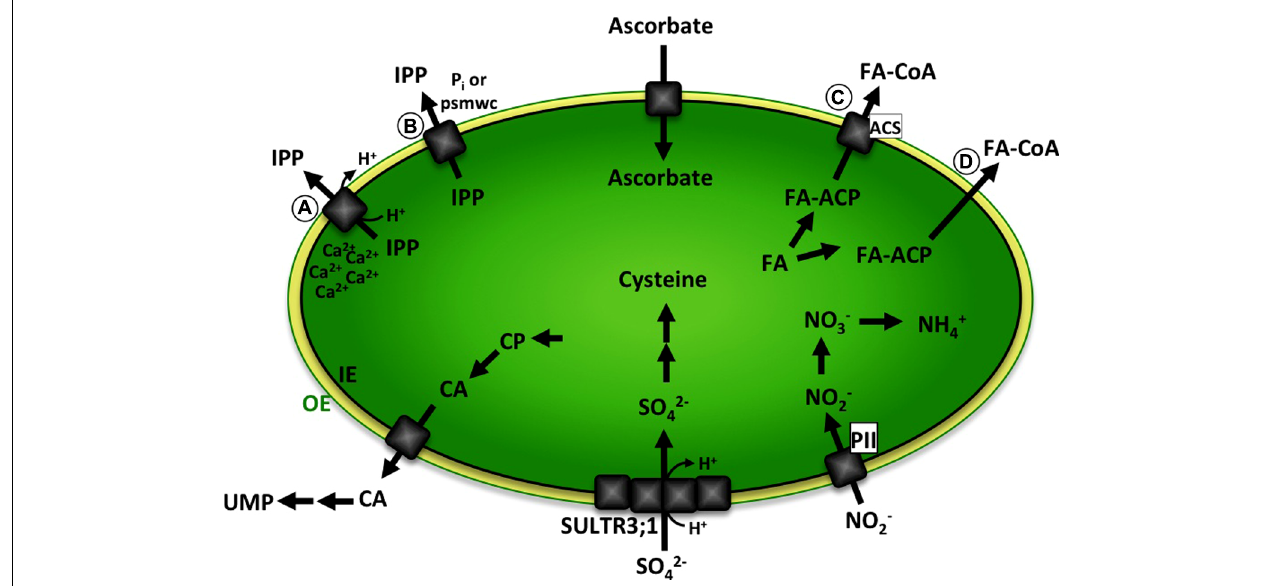
of UMP. Fatty acids are synthesized in the plastid, attached to a ACP and exported either (C) involving a transport protein and binding of ACS in the outer envelope or (D) by facilitated diffusion leading to formation of FA–CoA. The green line represents the plastid outer envelope membrane (OE).The black line represents the plastid inner envelope membrane (IE). Black arrows indicate enzymatic steps. Gray squares represent transport proteins. OE, plastid outer envelope membrane; IE, plastid inner envelope membrane; psmwc, phosphorylated small molecular weight compounds; IPP, Isopentenyl diphosphate; PII, plastidic PII protein; CP, Carbamoyl phosphate; CA, Carbamoyl aspartate; UMP, uridine monophosphate; FA, free fatty acids; FA-ACP, fatty acid – Acyl carrier protein; ACS, acyl-coenzyme A (CoA)